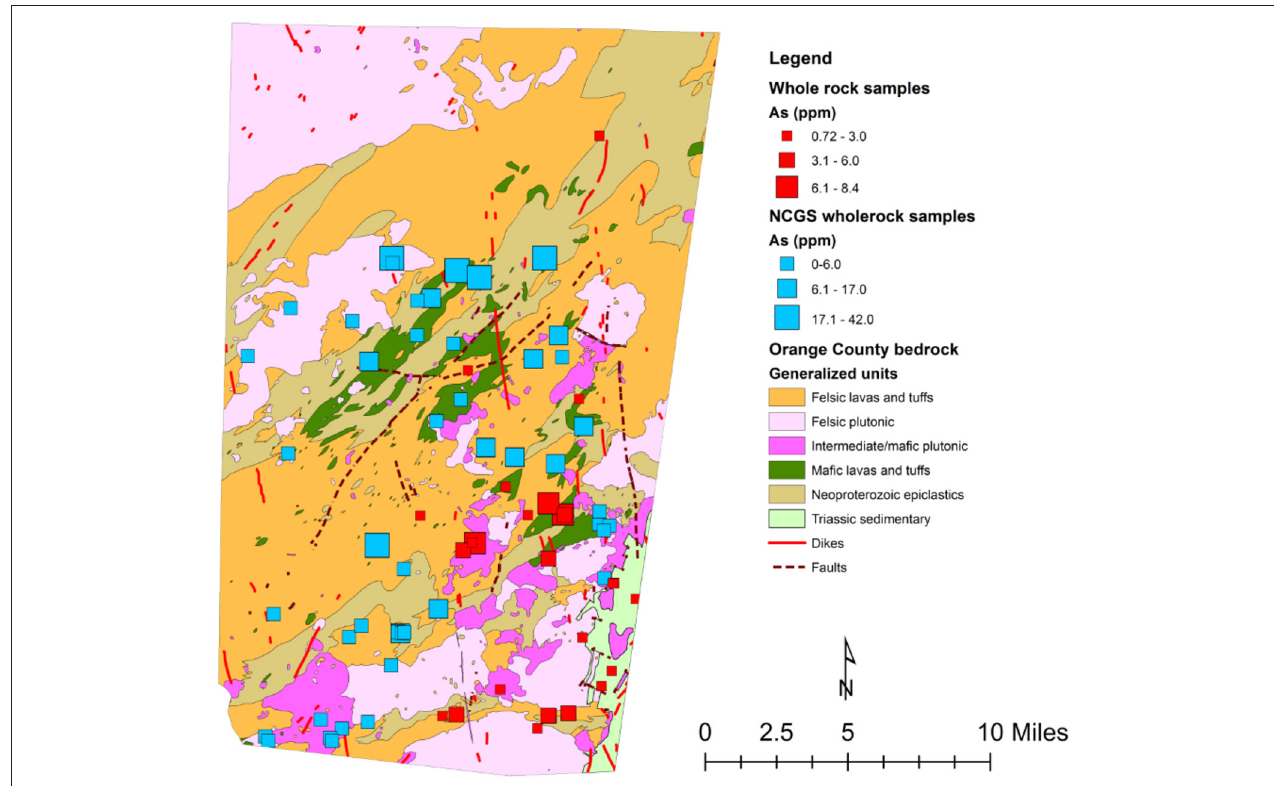
FIGURE 4 | Generalized map of Orange County showing sampling locations from this study (red boxes) and previous NCGS whole rock analysis (blue